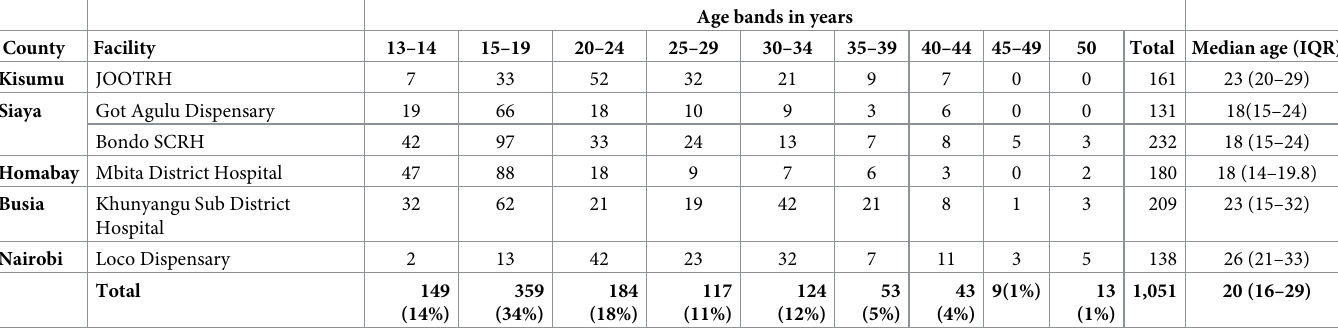
Table 1. Distribution of clients circumcised through ShangRing by county, facility, and age band (N = 1,051).